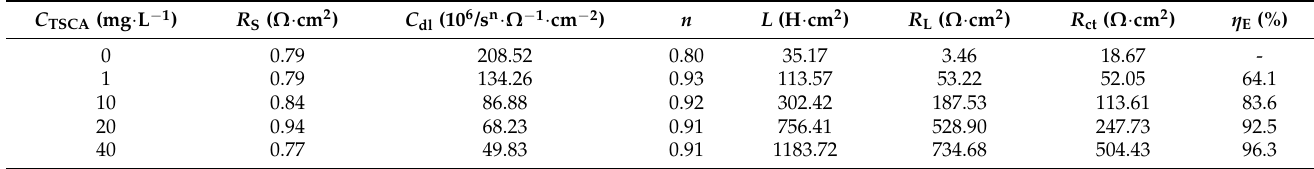
Table 2. Impedance parameters and corresponding inhibition efficiency for carbon steel immersed in 1 M HCl solutions with different contents of TSCA.